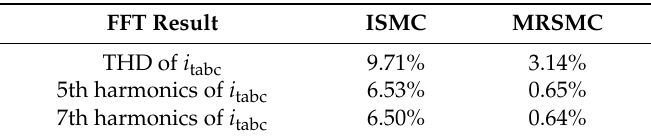
Figure 8. Simulation results of the MRSMC and ISMC for a DFIG system under distorted grid voltage. Table 2. Fast Fourier transform (FFT) of currents in Figure 8. ISMC: integral sliding mode control; MRSMC: multi-resonant-based sliding mode